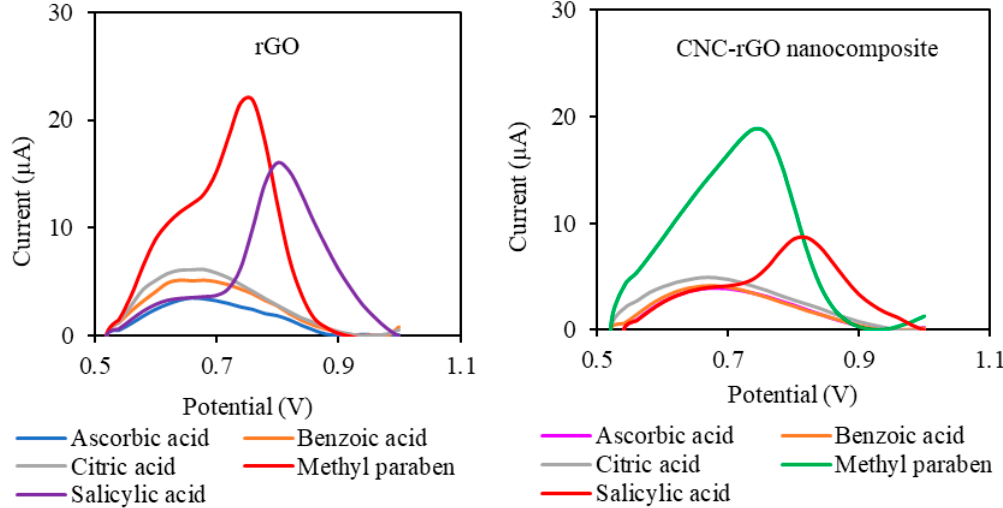
Figure 8. DPV voltammograms of rGO and CNC–rGO nanocomposite modified electrodes toward possible interfering species at a concentration of 4 × 10 − 4 M. Table 1. Comparison of the response of reduced graphene oxide (rGO) and cellulose nanocrystal (CNC) – rGO modified electrodes toward possible interference species at two different concentration ratios. MP—methyl paraben.